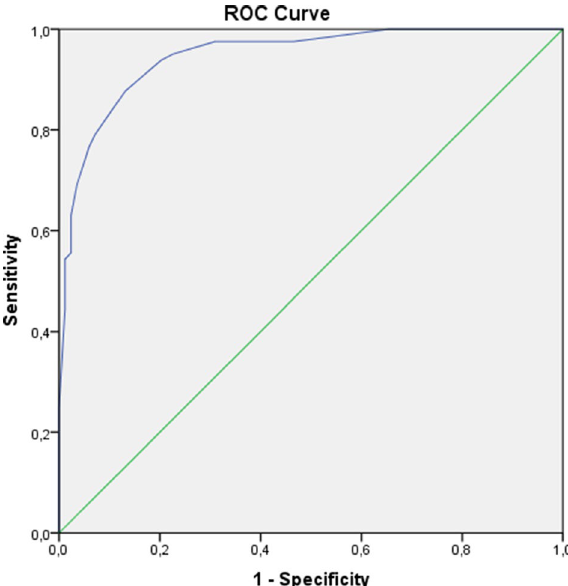
Figure 3. ROC curve analysis for the discriminatory ability of potential functional significant coronary bifurcation lesions. A cut-off value of BFSS of had 95% accuracy (sensitivity 77%, specificity 96%, p < 0.001. ROC–receiver operator’s curve; BFSS–bifurcation functional significance score.